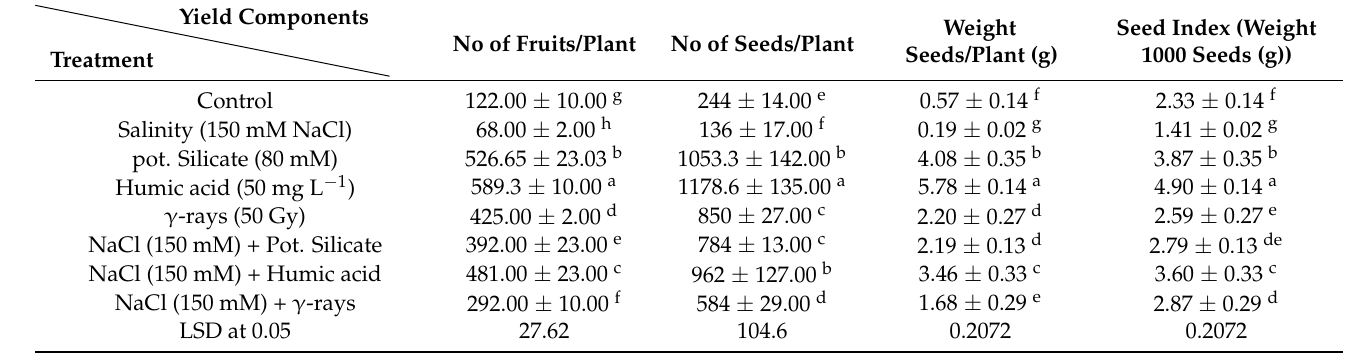
Table 4. Influence of biostimulants’ pretreatments on the yield components of coriander plants under salinity stress. Control and salinized stressed coriander samples were subjected to 80 mM pot. silicate, 50 mg L − 1 HA or soaked in water after exposure by 50 Gy γ -rays. Based on Duncan’s multiple range